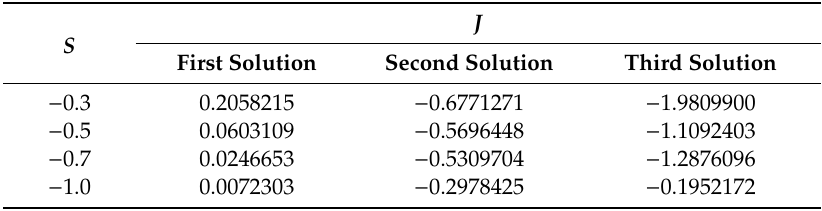
Table 7. Value of J as S varies at Pr 30,